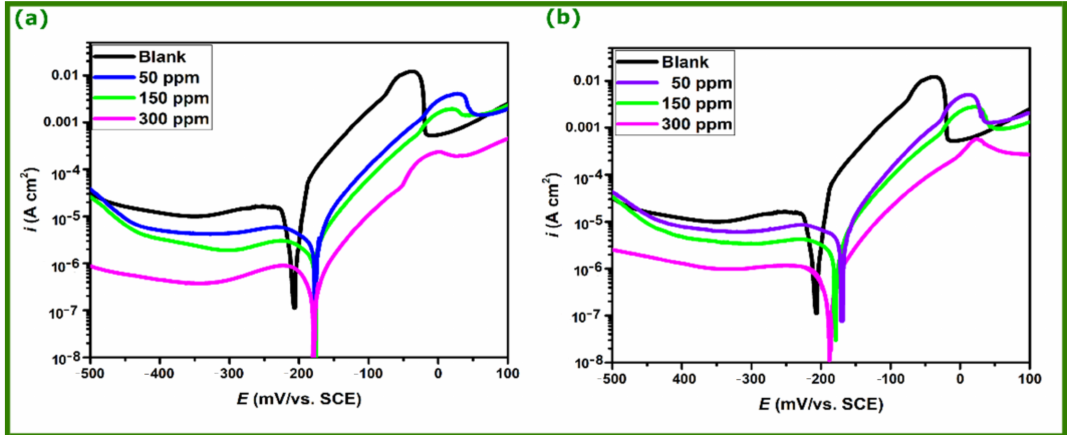
Figure 4. PPC of copper in 3.5 wt.% NaCl without and with various concentrations of thiazolidinedione derivatives at 298 K; ( a ): ATZD, ( b ):